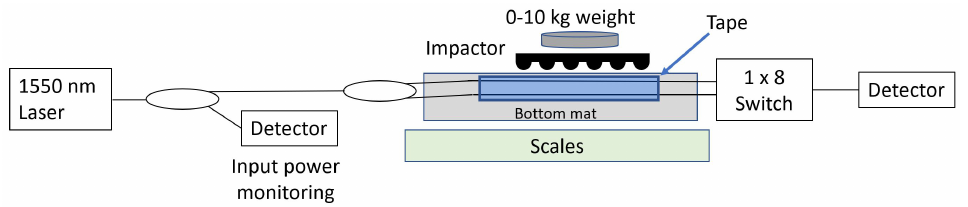
Figure 3. The experimental setup used for the measurements, showing the light passing through the impactor region within both fibre optic cables.